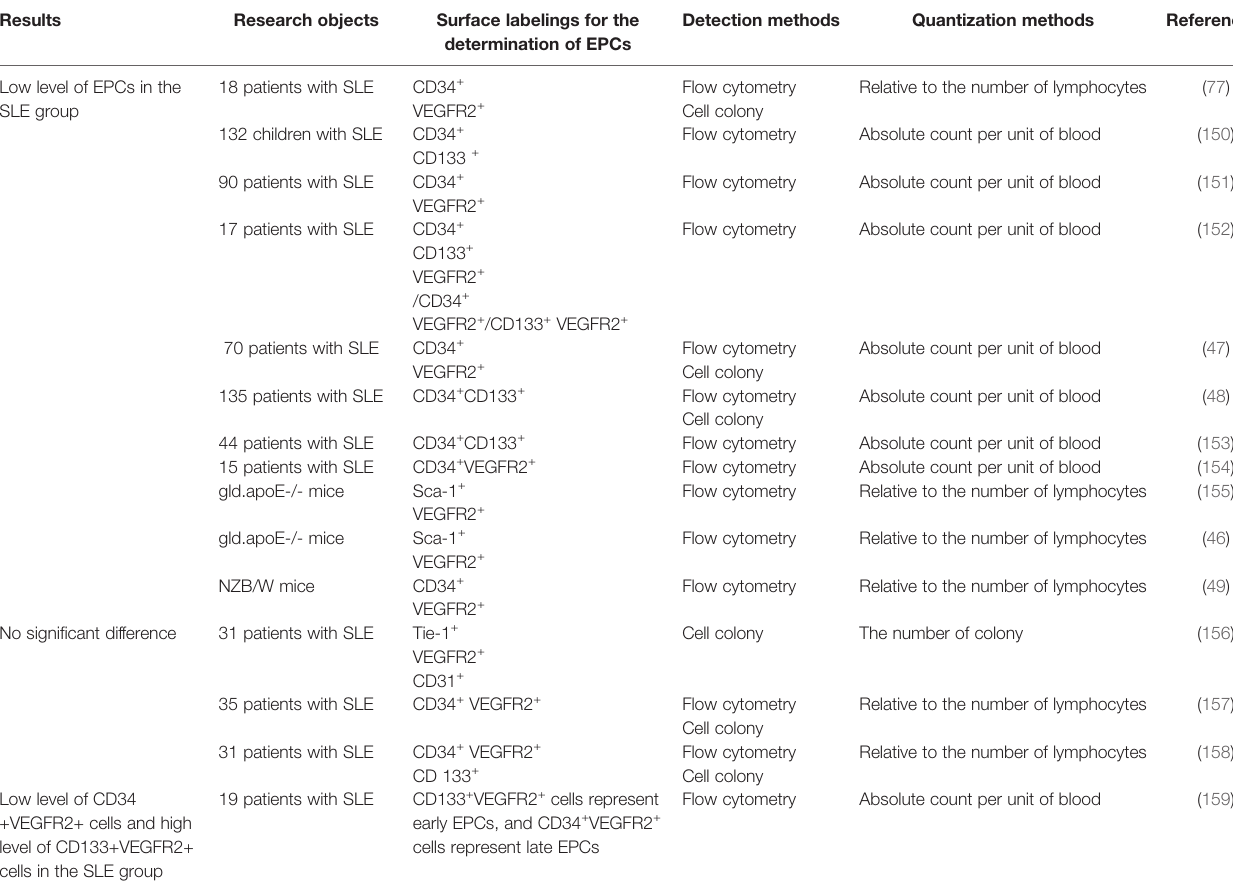
TABLE 2 | Quantitative analysis of circulating EPCs between SLE and healthy